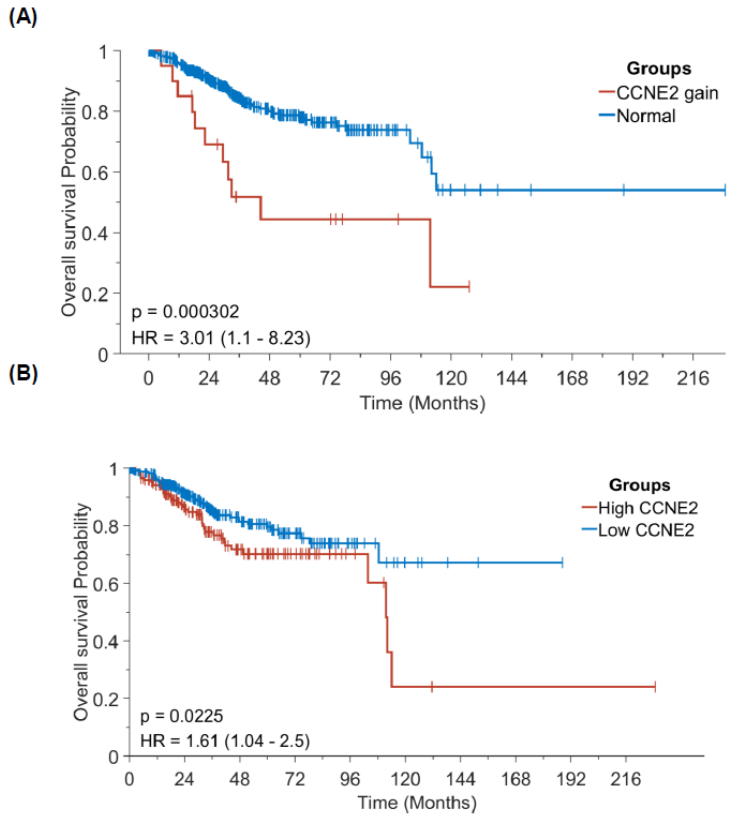
Figure 6. Prognostic significance of CCNE2 copy number variations and mRNA expression in patients with endometrial cancer (data source: Cancer Genome Atlas-Uterine Corpus Endometrial Carcinoma). Kaplan-Meier plots of overall survival according to CCNE2 ( A ) copy number variations and ( B ) mRNA expression.